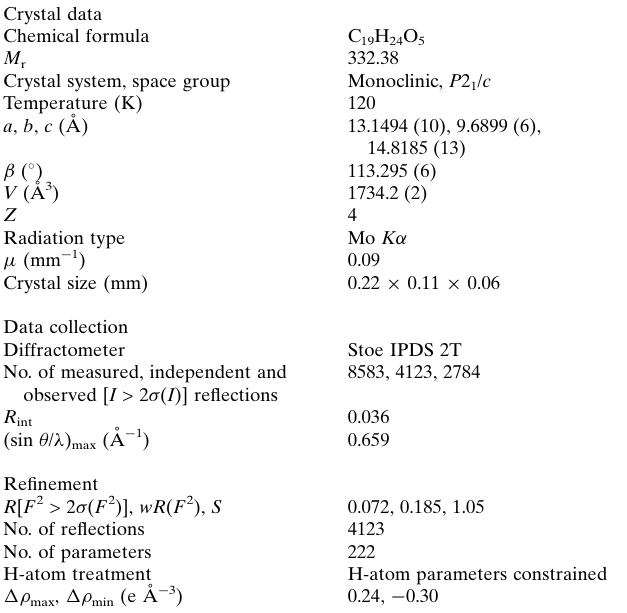
Table 2 Experimental details.